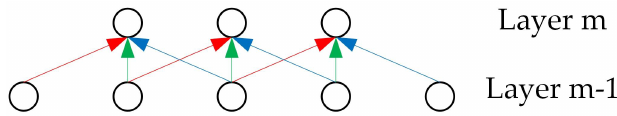
Figure 2. Shared weights in CNNs. The same color indicates the same weight.